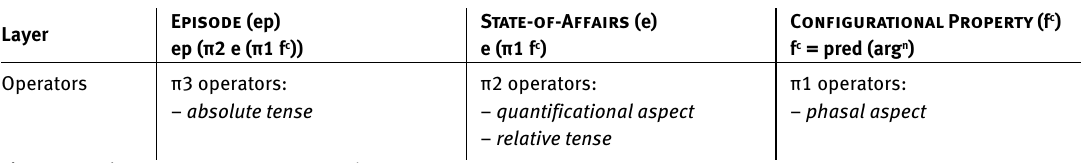
Figure 1: Major tense ‒ aspect operators in